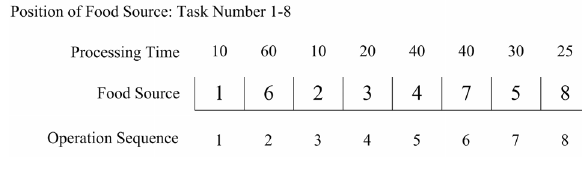
Fig. 3. Illustration of the food source